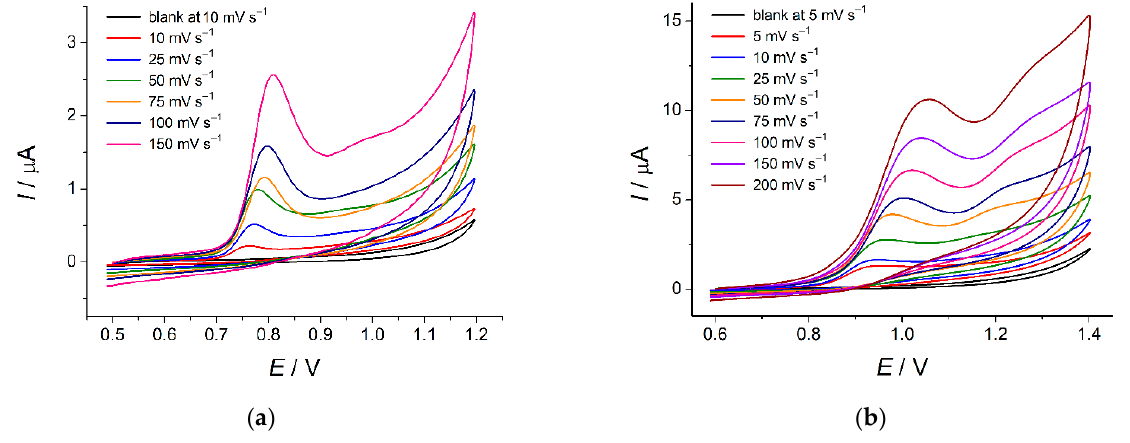
Figure 8. Cyclic voltammograms of dyes on the MnO 2 nanorods-modified electrode in phosphate buffer pH 7.0 at various potential scan rates: ( a ) 30 μM of tartrazine; ( b ) 100 μM of brilliant blue FCF.